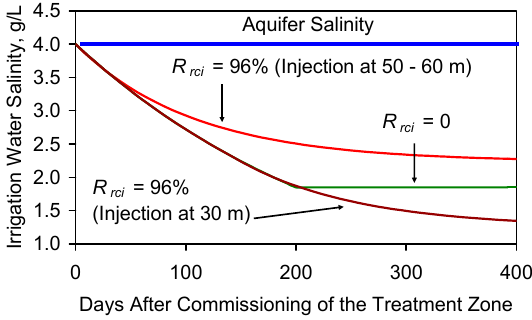
Figure F3. Change in salinity of the irrigation water abstracted from the modeled Aquifer Treatment Zone with time. Aquifer salinity = 4 g/L. Process Flow Diagram = Figure 20. R rci = Reinjection ratio = 480/500. z 8 = ( n /( n + y )); n = 0 m 3 · day − 1 ; Assumptions: (i) No Injection; n = 0 m 3 · day − 1 . Leakage = 0%; (ii) Injection at 50–60 m from the abstraction well; n = 0 m 3 day − 1 ; Leakage = 0%; (iii) Injection at 30 m from the abstraction well; n = 0 m 3 · day − 1 . Leakage = 0%; Aquifer Thickness = 1 m; Rate Constant = Figure B2b.